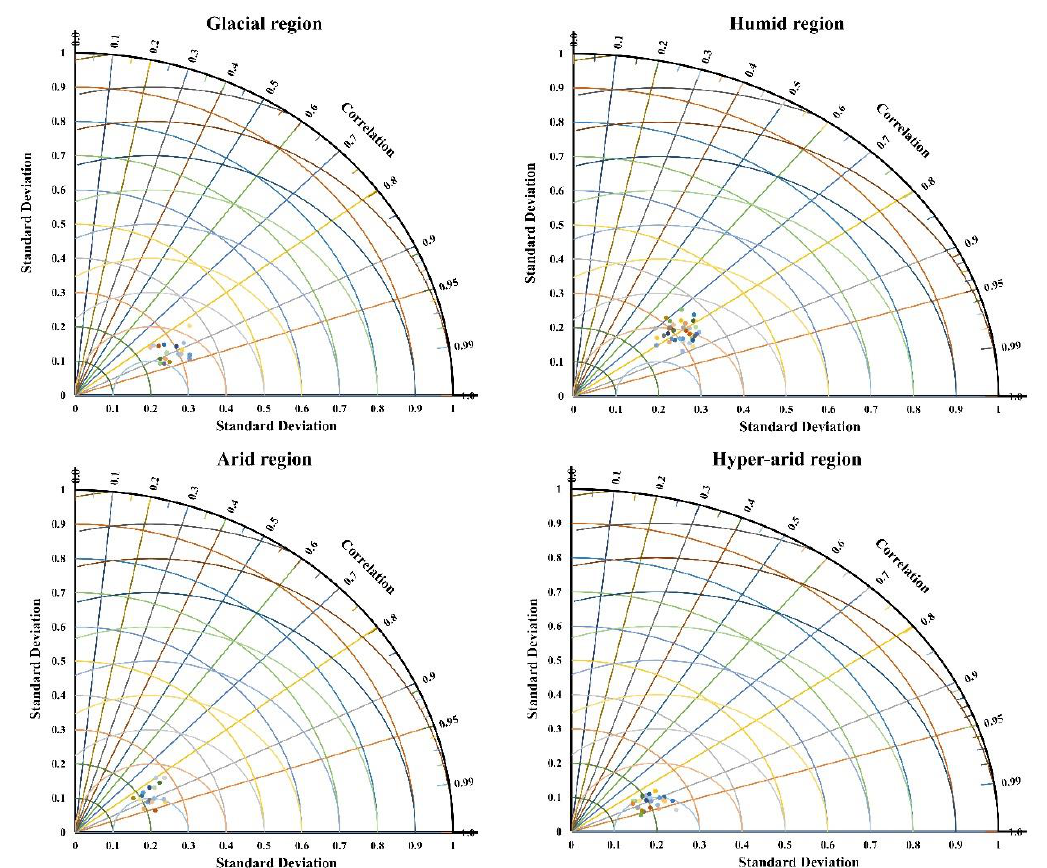
Figure 12. The Taylor diagramshows the spatial variability of SPI-12 time-series of RWALS-MPSD against every RG in each climate region.